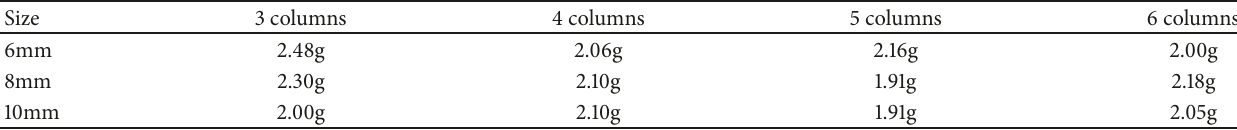
Table 1: Mass parameters of convex pit models.